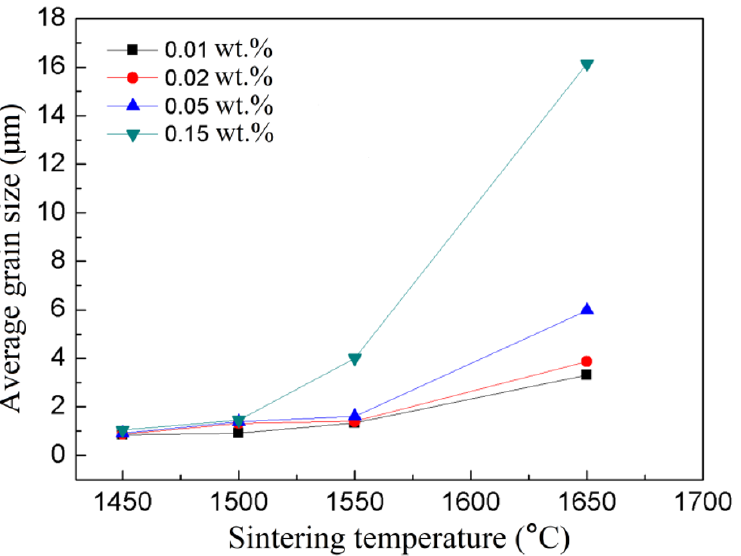
Figure 2. Average grain size versus vacuum sintering temperature of Y 2 O 3 samples with different CaO contents.